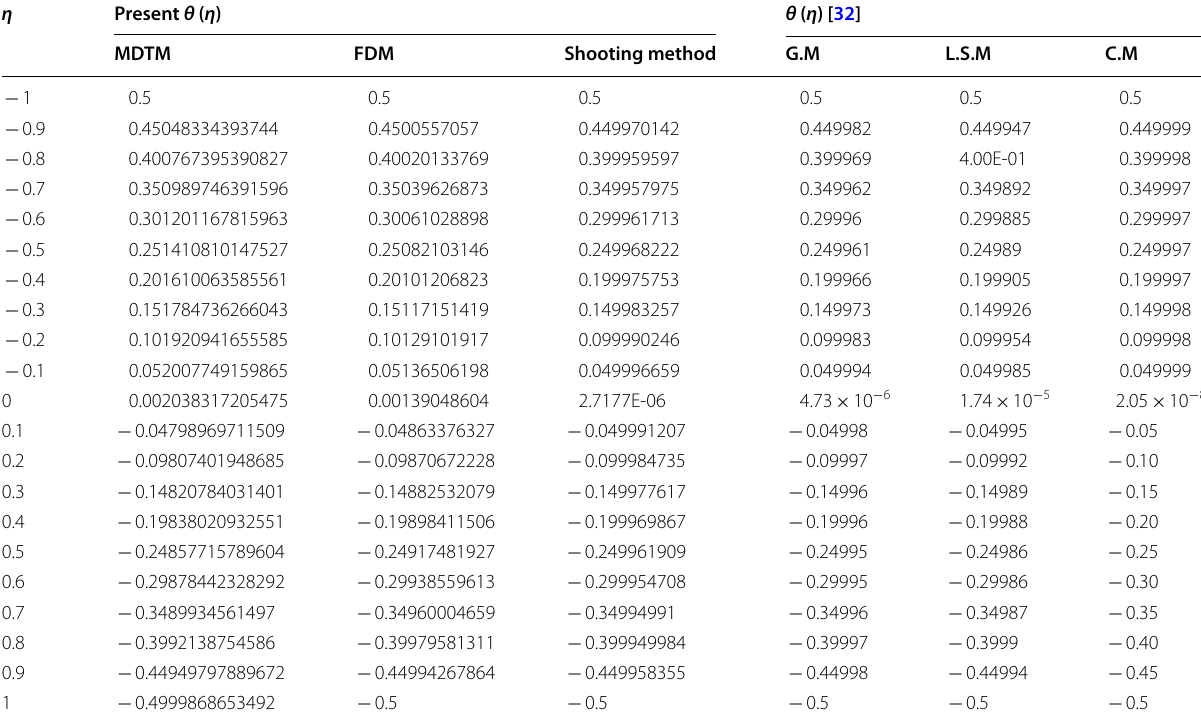
Table 3 Comparison solution by MDTM, FDM, and shooting method with GM, LSM, and CM [32]) for θ ( η ) when ϕ Ha 3, R 2, Ec 1, Pr 6.2, and α d = = = =